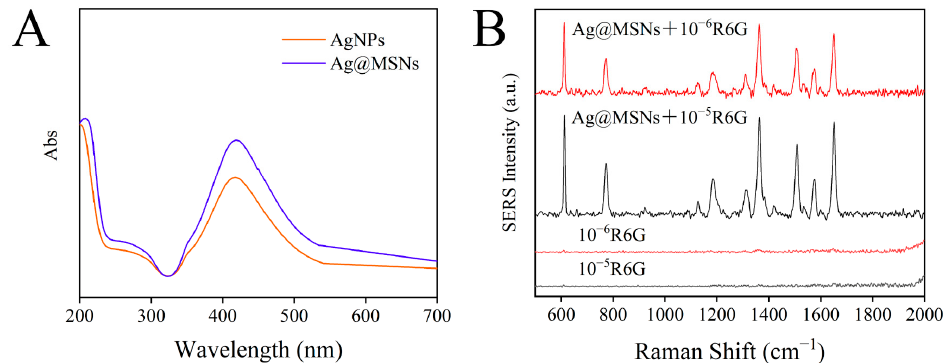
Figure 6. The UV–Vis absorption spectrum of AgNPs and Ag@MSNs ( A ); SERS spectrum of R6G and R6G adsorbed on Ag@MSNs ( B ).